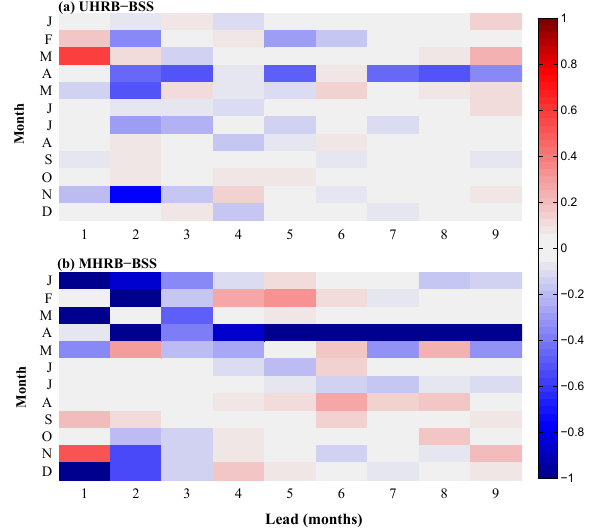
Figure 10. Brier skill score (BSS) of NMME forecast for hydro- logical drought events. Here, a hydrological drought event happens when the SSI1 value is below − 1. The reference forecasts are sim- ulations from ESP experiment. The predictions and simulations are carried out with the human activities module switched